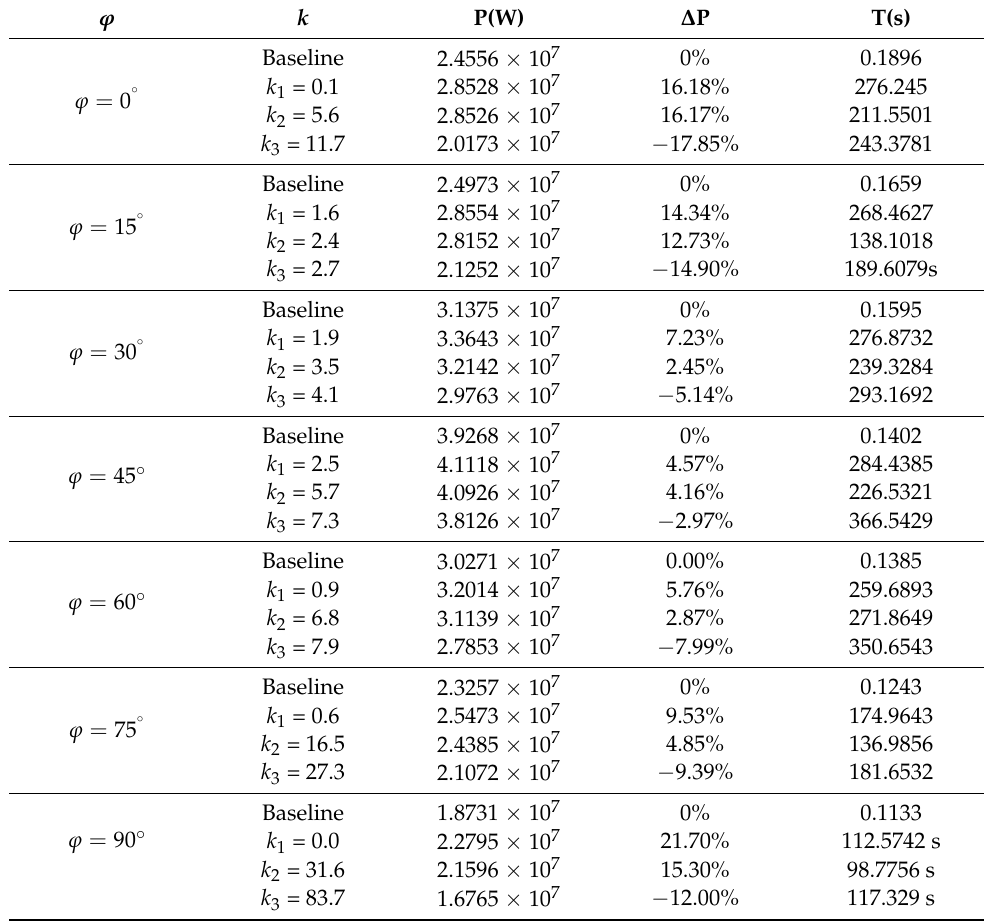
Table 3. The different adaptive k with the varying wind direction ϕ